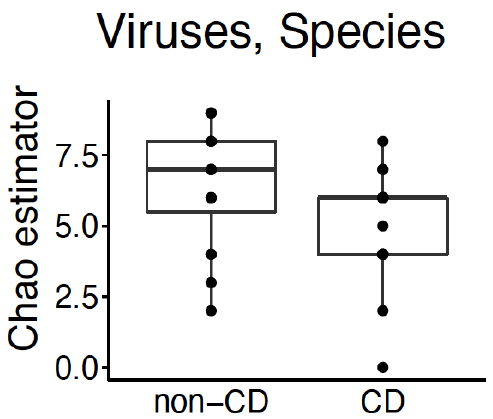
Figure 2. Cross-sectional analysis of viral species’ alpha diversity in the breast milk of subjects with CD on a gluten-free diet compared with healthy controls. Statistically significant difference in alpha diversity of viral species between the breast milk of subjects with CD on a gluten-free diet and healthy controls based on Chao1 estimator ( p -value < 0.05).